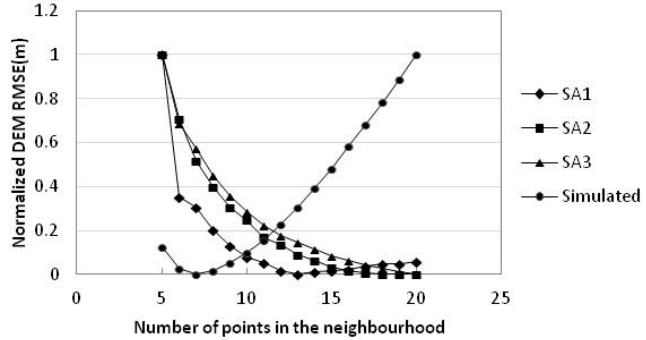
Figure 5. Plot of DEM RMSEs of three study areas and simulated data by number of points in the neighbourhood.